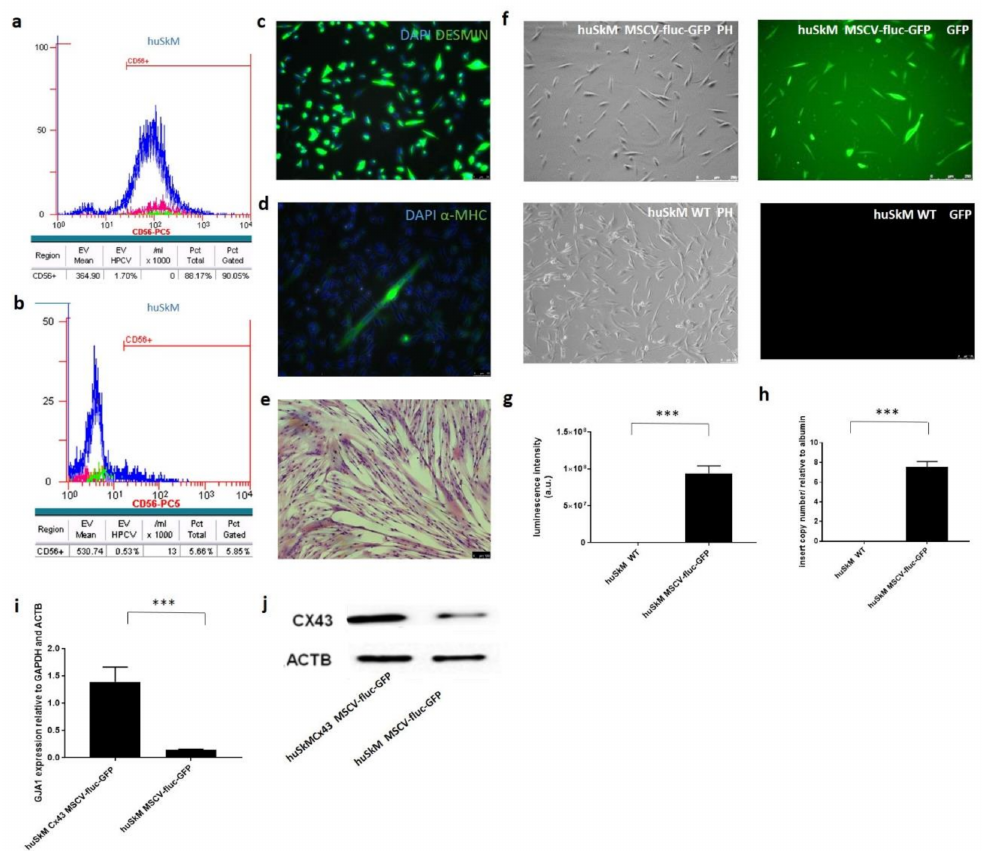
Figure 2. Characteristics of huSkM and evaluation of the efficiency of huSkM transduction with MSCV-fluc-GFP reporter vector. ( a ). Flow cytometry detected approximately 90% of CD56 + huSkM cells in the isolated skeletal muscle population. ( b ). Isotype control was performed in parallel (IgG1-PC5). ( c ). Immunofluorescence of huSkM stained with an anti-desmin antibody (green) and nuclear dye DAPI (blue), scale bar = 50 µ m. ( d ). Immunofluorescence of huSkM stained with an anti- α -MHC (myosin heavy chain) antibody (green) and nuclear dye DAPI (blue), scale bar = 50 µ m. ( e ). Multinuclear tube formation test confirmed the ability of the cells to differentiate in vitro, scale bar = 50 µ m. ( f ). huSkM transduced with MSCV-fluc-GFP-lentiviral reporter vector vs. negative control cells. ( g ). Firefly luciferase luminescence activity measured in transduced cells (huSkM MSCV- fluc-GFP) vs. negative control cells (huSkM WT) in triplicate, *** p > 0.001. ( h ). MSCV-GFP-luc insert copy number in huSkM cells (7.5 copies) vs. untransduced control (huSkM WT) relative to albumin, *** p < 0.003. ( i ). Relative expression of the gene encoding for Cx43 in pCiNeo-CX43-transfected huSkM 48 h after the transfection vs. untransfected cells, *** p < 0.001. ( j ). Overexpression of Cx43 protein in pCiNeo-CX43-transfected huSkM vs. untransfected cells 48 h after the transfection. ACTB was used as a loading